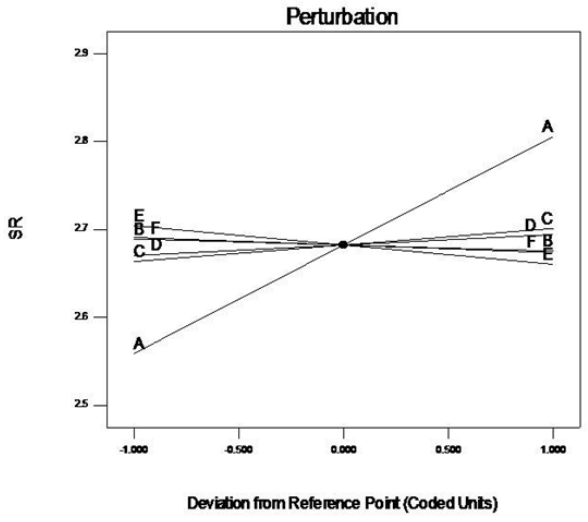
Figure 4: Perturbation plot showing the effect of individual parame- ters on